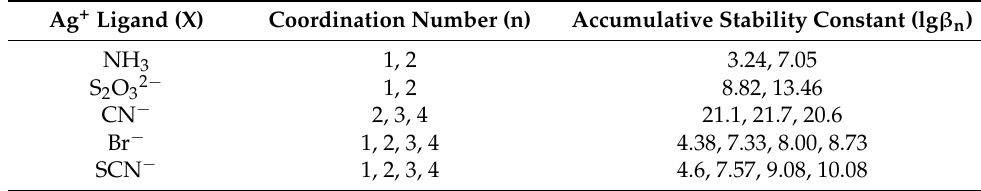
Figure 3. Removal experiment of AgCl impurities. ( a ) The original sample etched by diluted aqua regia; ( b , c ) the sample surface after treatment with concentrated ammonia; ( d ) the sample surface after further treatment with 1 mol/L sodium thiosulfate solution. Table 1. Common Ag + ligands, coordination numbers, and accumulative stability